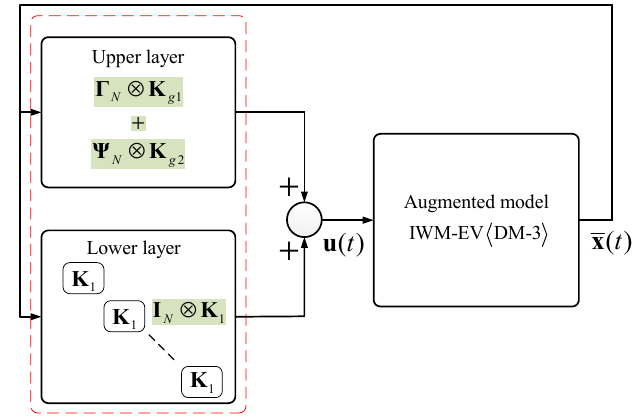
Figure 13. Structure of the hierarchical decentralized LQR using DM-3.